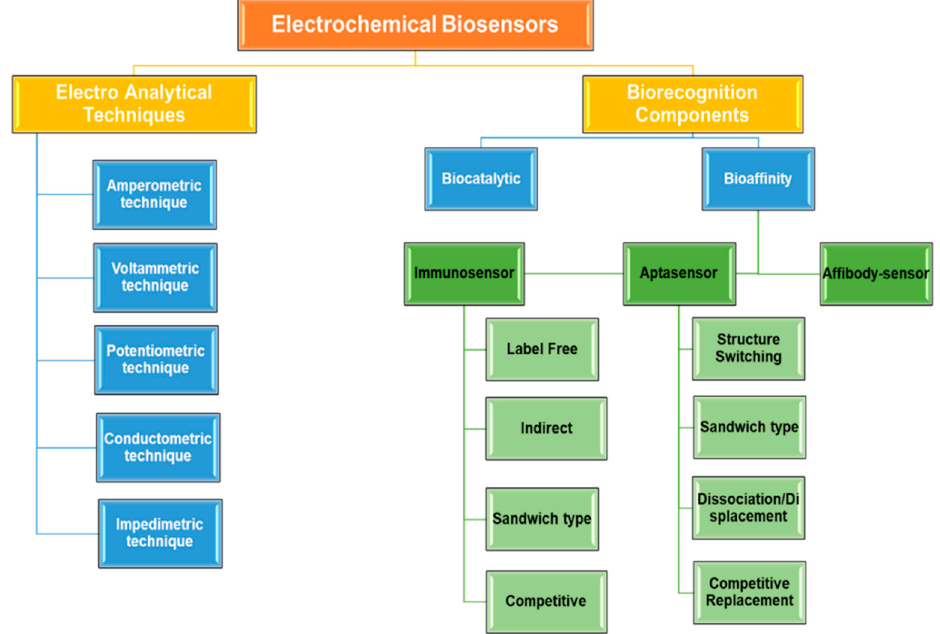
Figure 2. Classification ECBs. Left-hand side shows the classification with respect to electroanalytical techniques (EATs) and the right-hand side shows classification with respect to biorecognition components (BRCs).